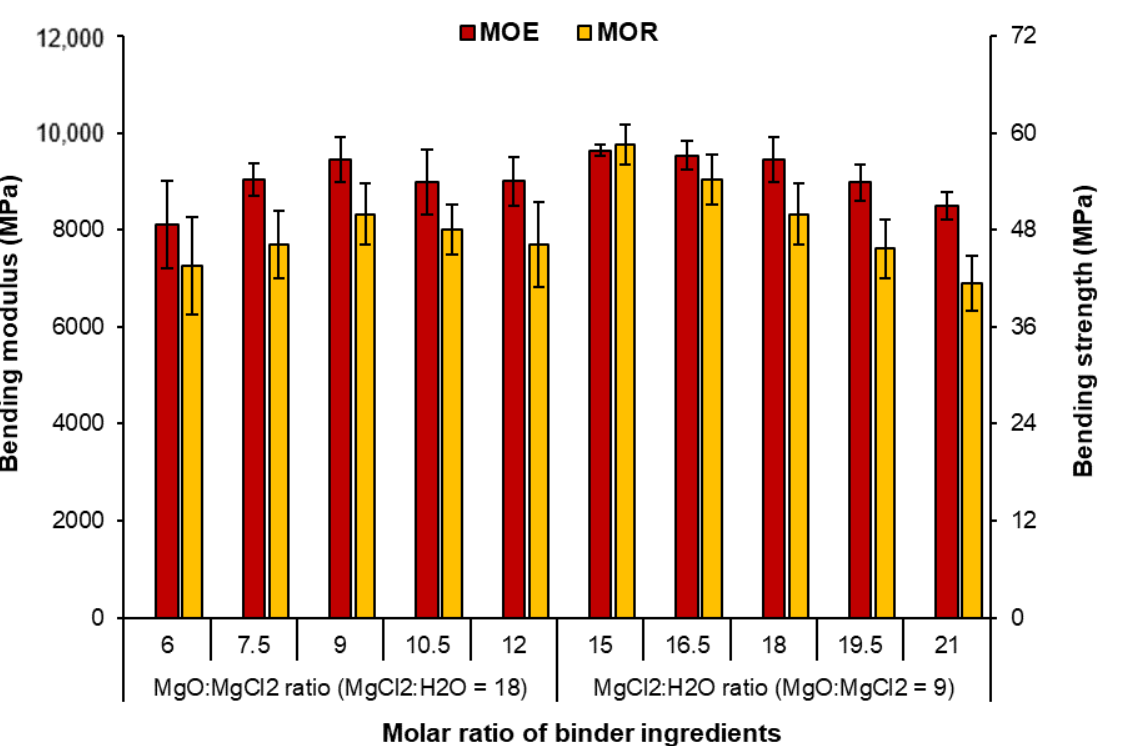
Figure 6. Bending properties of plywood samples using MOC binders with different molar ratios of the components.